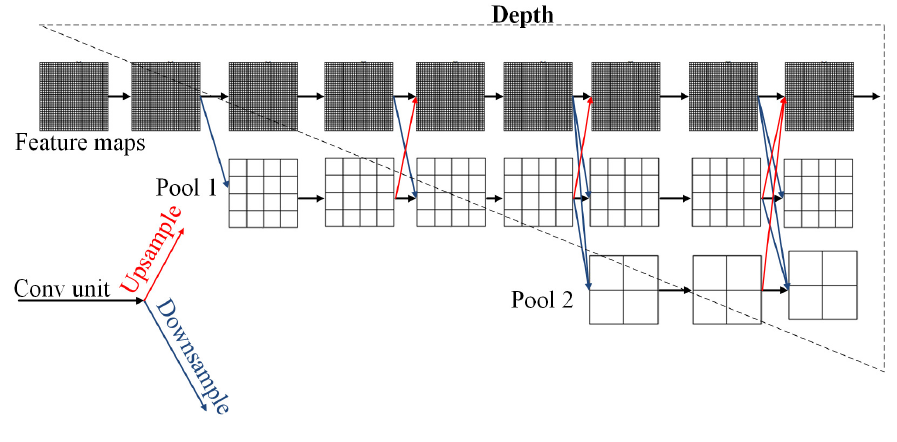
Figure 3. High-resolution network layout.